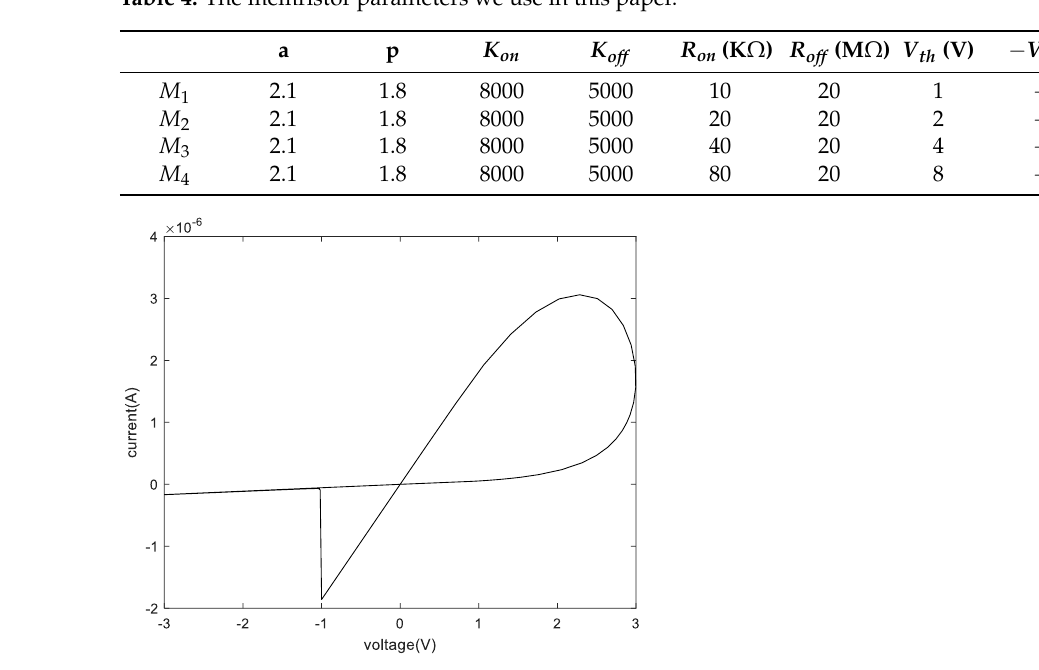
Table 4. The memristor parameters we use in this paper.